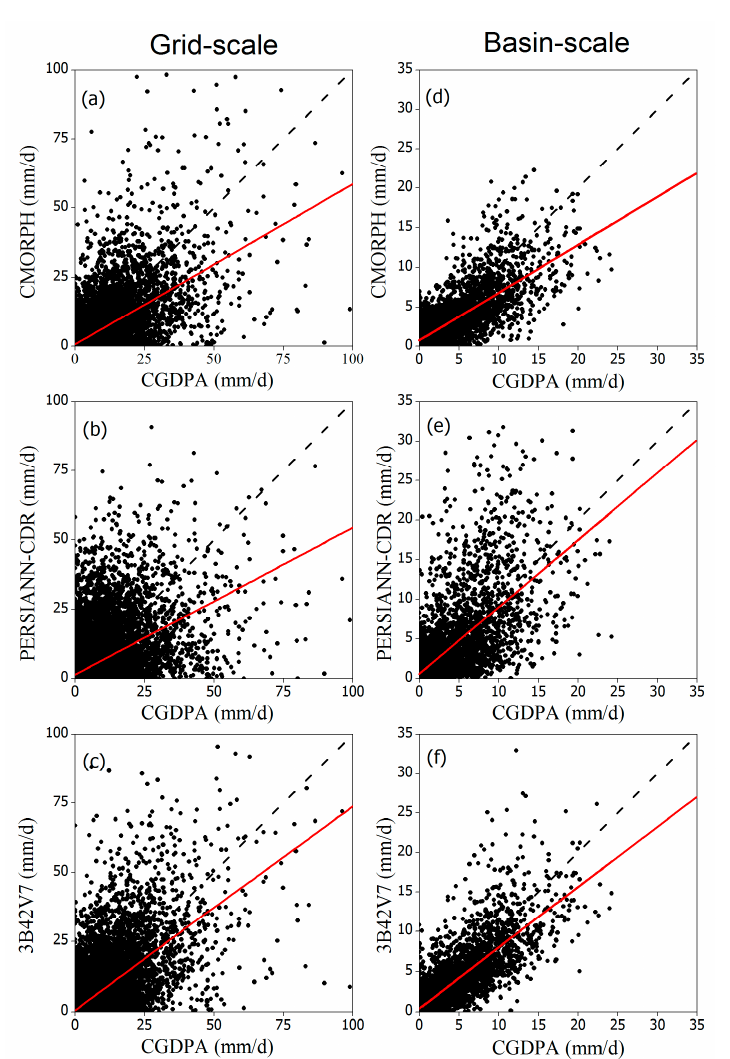
Figure 3. Scatterplots of grid-based precipitation comparison at seven selected grid boxes (first column) and basin-averaged precipitation comparison (second column) in the Dadu River basin: ( a , d ) for CMORPH, ( b , e ) for PERSIANN-CDR, ( c , f ) for 3B42V7. The diagonal dash line is black, and the best fit line (using the least square method) is red.